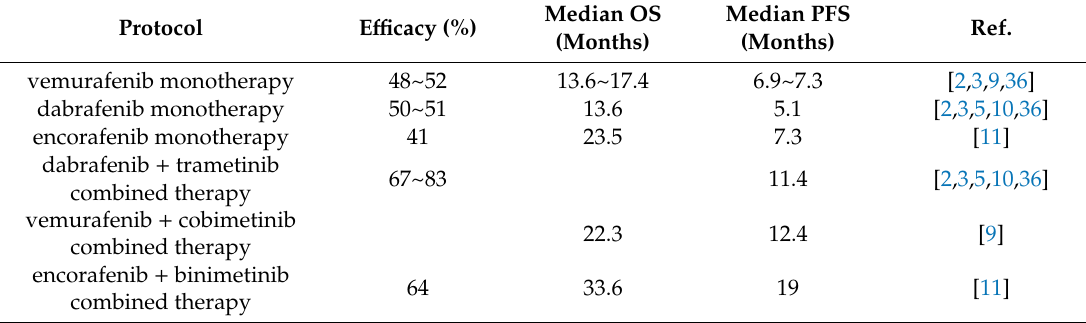
Table 3. Summary of the e ffi cacies of BRAF inhibitor monotherapy and combined